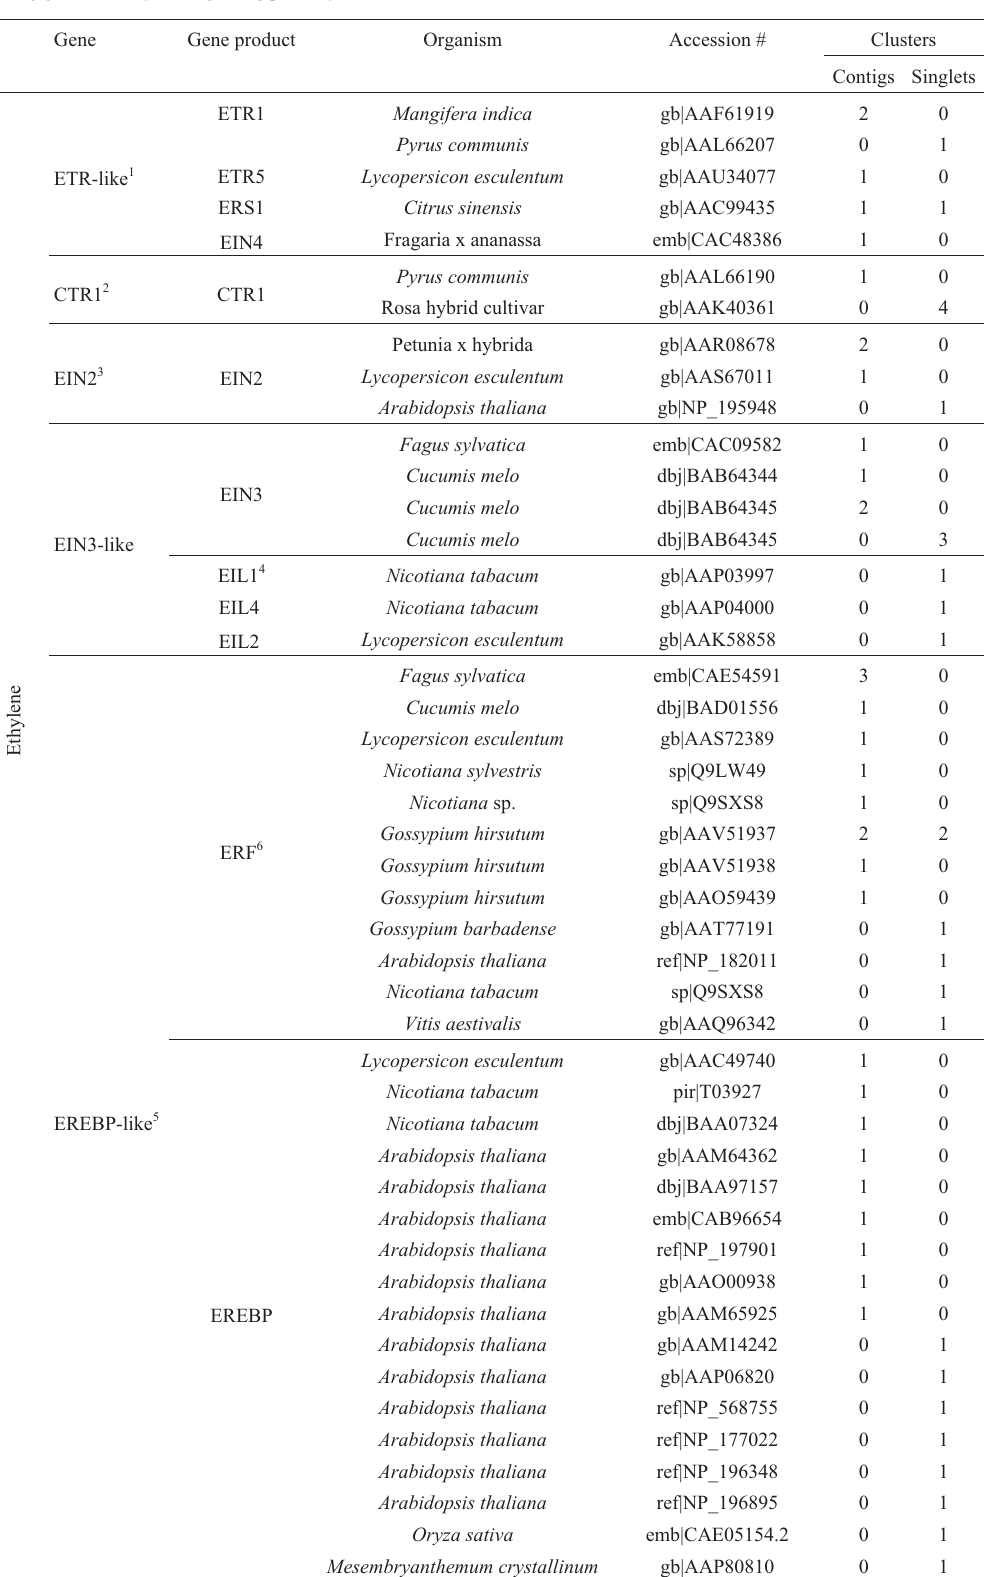
Table 3 - Ortholog genes of Ethylene signaling pathways found in the Citrus EST